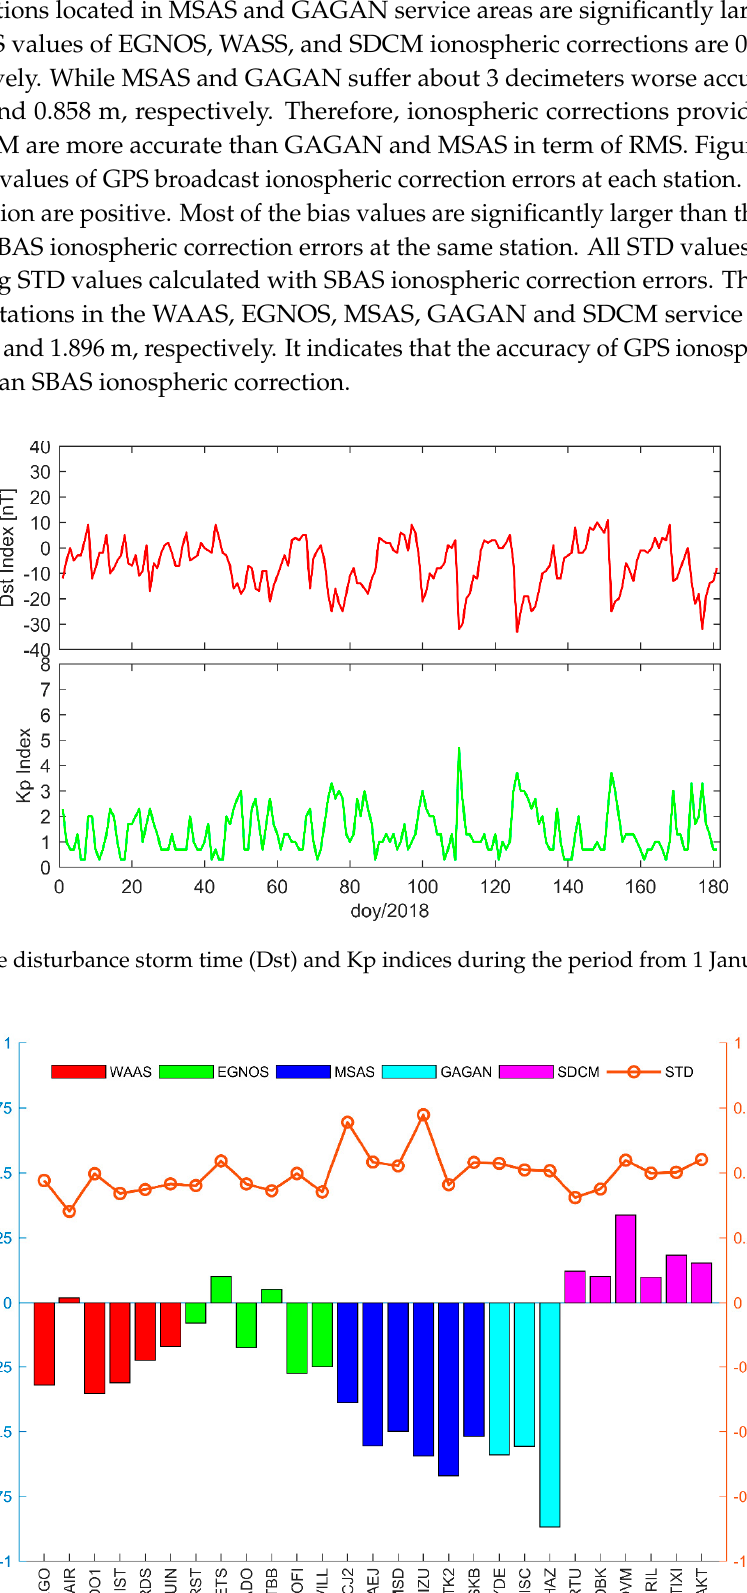
Figure 16. The bias and STD values of GPS broadcast ionospheric correction errors for each selected IGS station. 4. Discussion